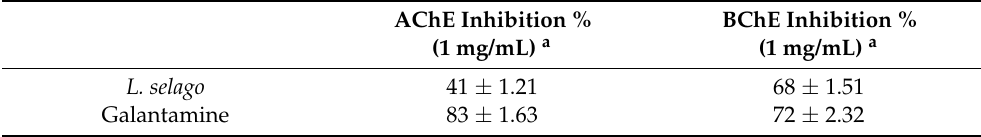
Table 3. Acetylcholinesterase and butyrylcholinesterase inhibitory activities of the L. selago